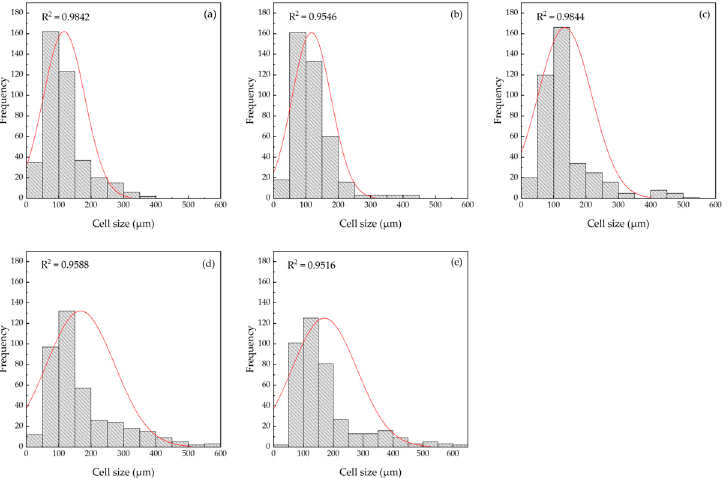
Figure 9. NRL foam composites distribution curve with various BLF loadings ( p < 0.05, n = 400): ( a ) NRL-FN-BLF0.0; ( b ) NRL-FN-BLF2.5; ( c ) NRL-FN-BLF5.0; ( d ) NRL-FN-BLF7.5; ( e ) NRL-FN- BLF10.0.